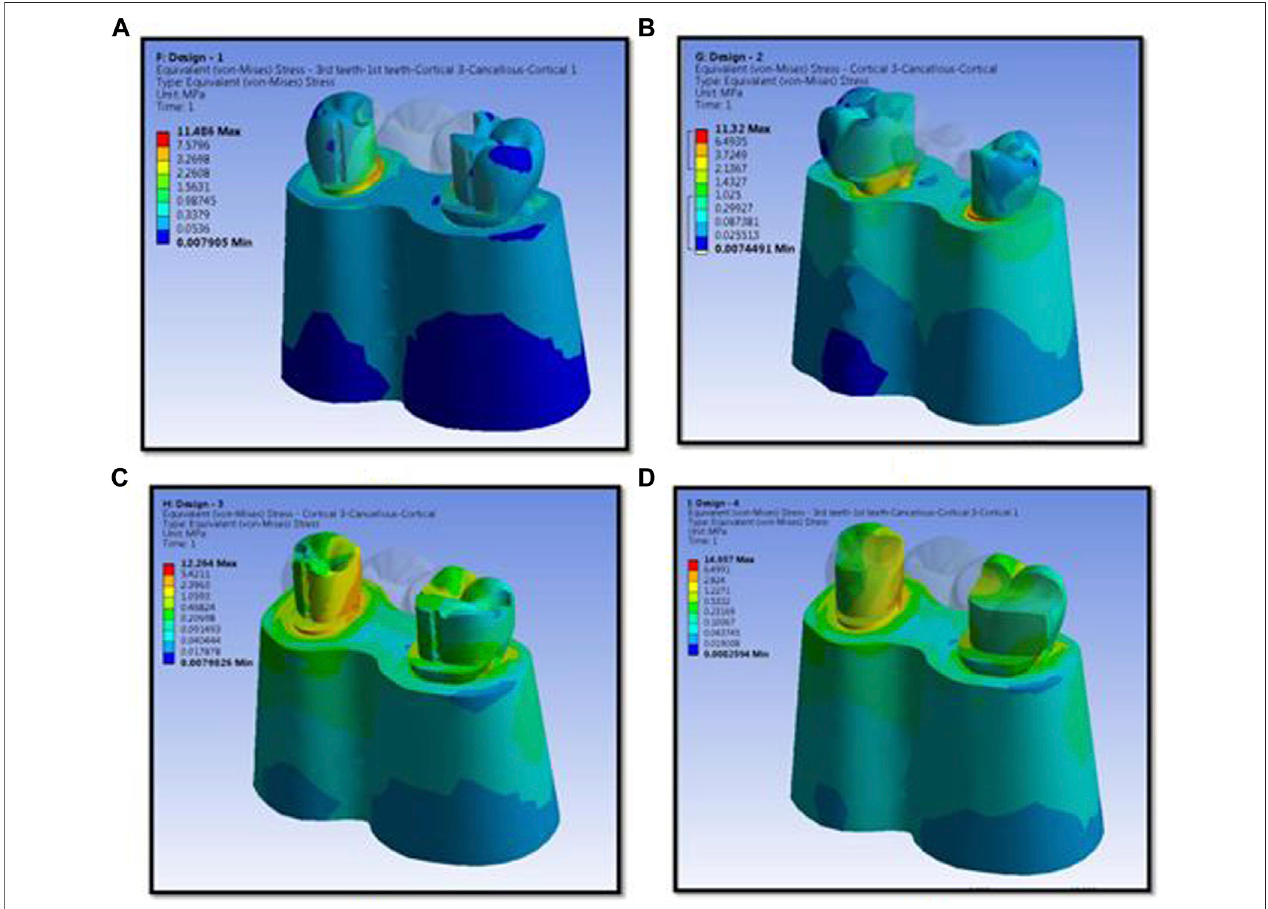
FIGURE 8 | Stress distribution in cortical bone, cancellous bone, and teeth for design 1 (A) , design 2 (B) , design 3 (C) , and design 4 (D) used in fi nite element analysis.